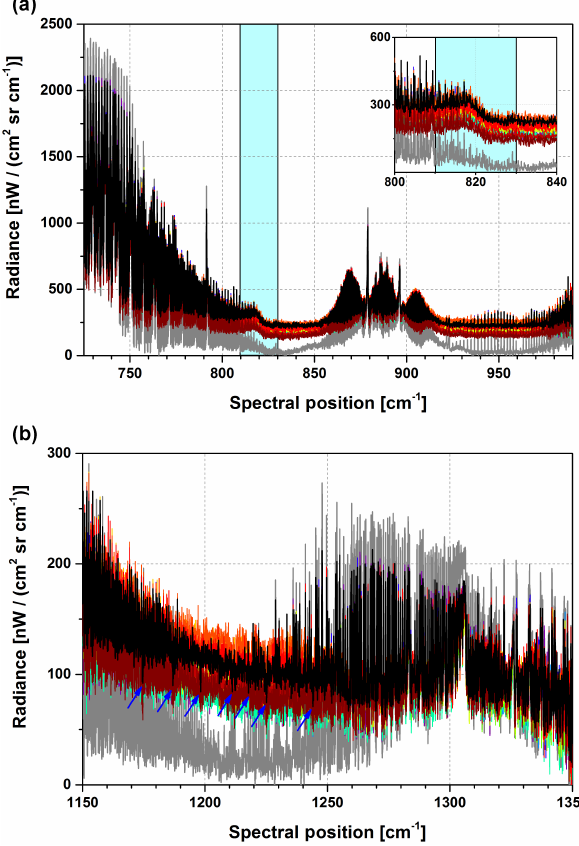
Figure 4. (a) MIPAS-STR channel 1 spectra of approximately hor- izontal limb views. Colored spectra: observations inside PSC in the time interval of the in situ PSC observations. Black spectrum: PSC observation analyzed in Sect. 3 (elevation angle − 0.25 ◦ vs. horizon, flight altitude 18.507km, and tangent altitude 18.445km). Grey spectrum: corresponding observation under cloud-free conditions. Spectral region of a “shoulder-like” signature around 820cm − 1 at- tributed to β -NAT particles shaded in cyan. (b) Same as panel (a) but for MIPAS-STR channel 2. Blue arrows denote prominent H 2 O ( g ) absorption signatures from scattering of tropospheric radi- ation by PSC